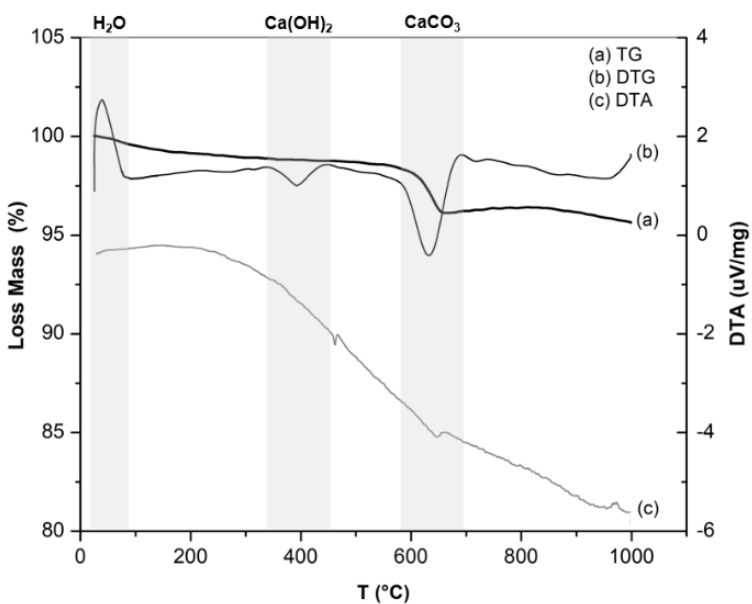
Figure 3. TG/DTA curves for the steel slag